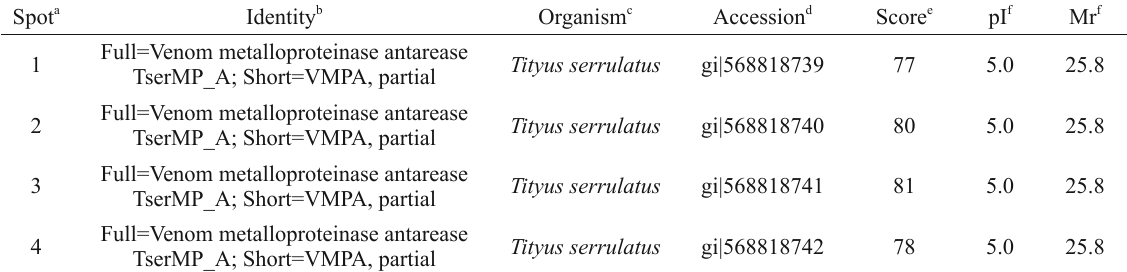
List of proteins identi fi ed in the venom of Tityus stigmurus by MALDI TOF/TOF.